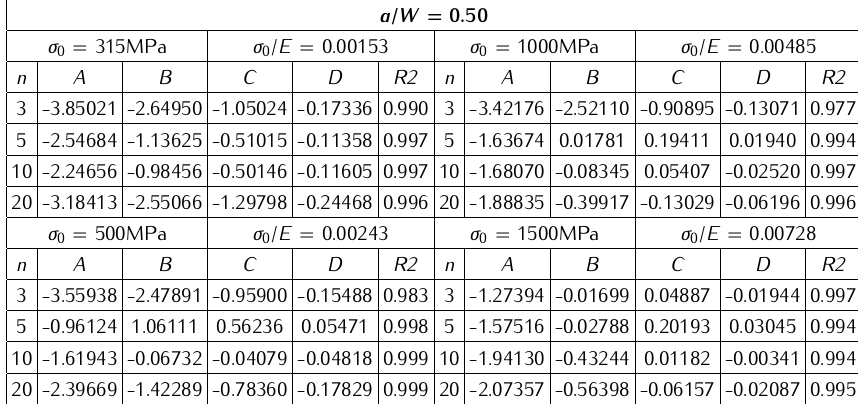
Table 6. The coefficients of equation (13) for CC(T) specimen with the crack length a / W